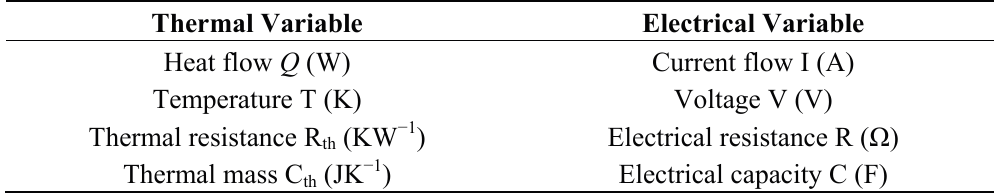
Table 1. Analogies between thermal and electrical